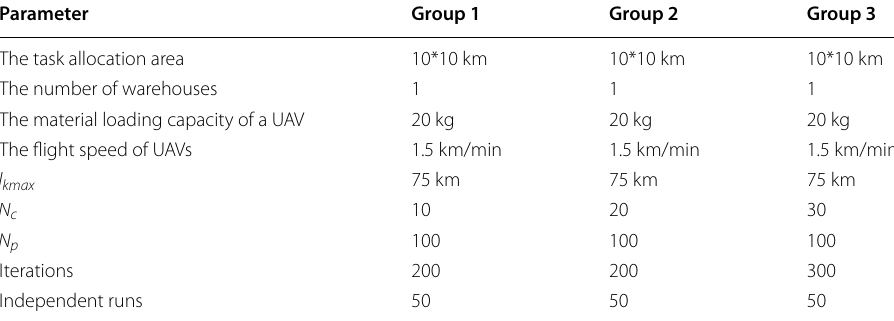
Table 2 The parameter settings of task allocation